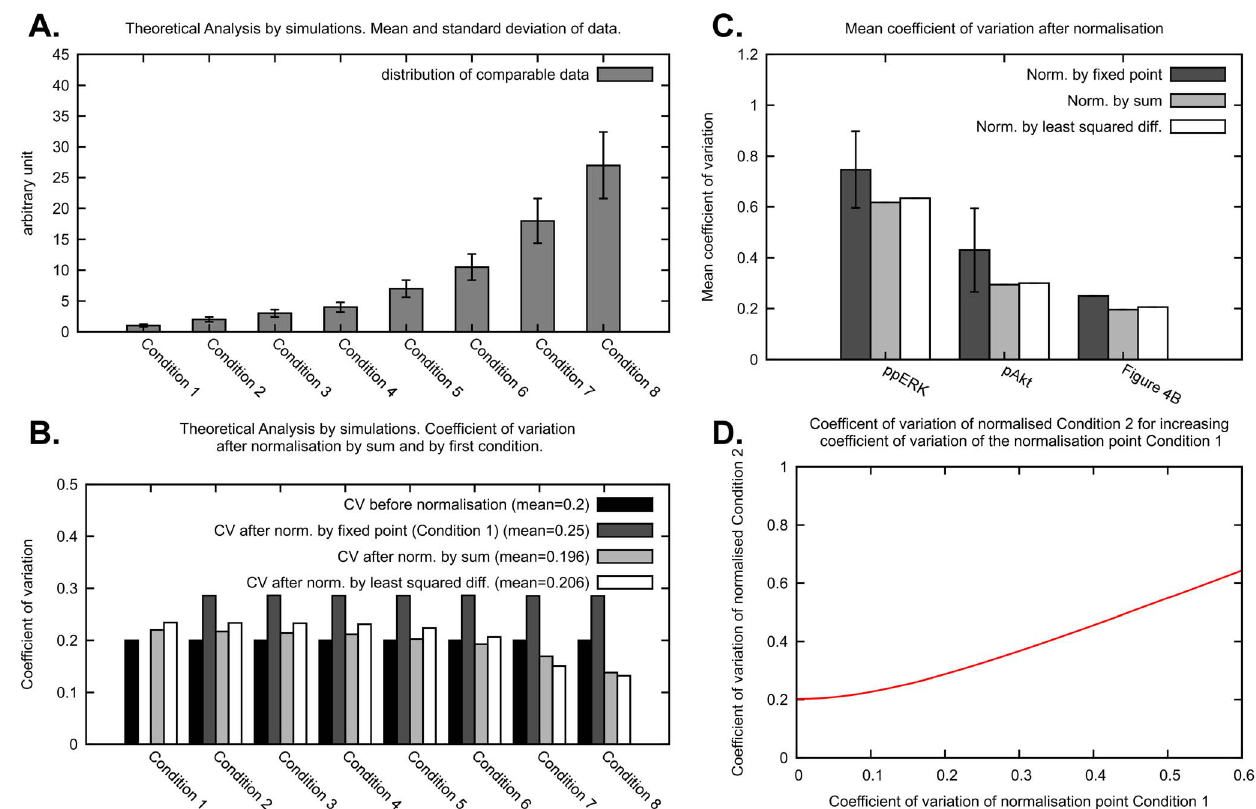
Figure 3. Effect of the normalisation on the CV of the normalised data. (A) Distribution of the data in a simulated scenario. In our theoretical analysis of the effects of the normalisation on the variability of the normalised data we consider a distribution of the response to eight conditions. We use log-normal distributions with CV 0.2 and mean of the response to the conditions from 1 to 8 as 1, 2, 3, 4, 7, 10.5, 18, 27. (B) CVs are shown for the distribution of the simulated data before normalisation, after normalisation by first condition, after normalisation by sum of all data points in a replicate and after normalisation by least squared differences. The mean CV is computed as the average across the eight conditions. (C) Data from Figure S3 of [25] (Figure S5 in this publication) were normalised using different normalisation strategies and the mean CV of the resulting normalised data is shown. As the mean CV obtained by the normalisation by fixed point depends on the choice of normalisation point, we report the mean and standard deviation obtained. We also report the mean CV obtained using ppERK and pAkt data and we compare them with the theoretical results of Figure 3B. (D) Before normalisation, the response to Condition 2 has a CV of 0.2, as shown in Figure 3A. Condition 2 is then normalised by fixed point, with Condition 1 as normalisation point. Here we show how the CV of normalised Condition 2 changes for increasing CV of the normalisation point Condition 1. the band of the untreated or neutral condition. Formally, this